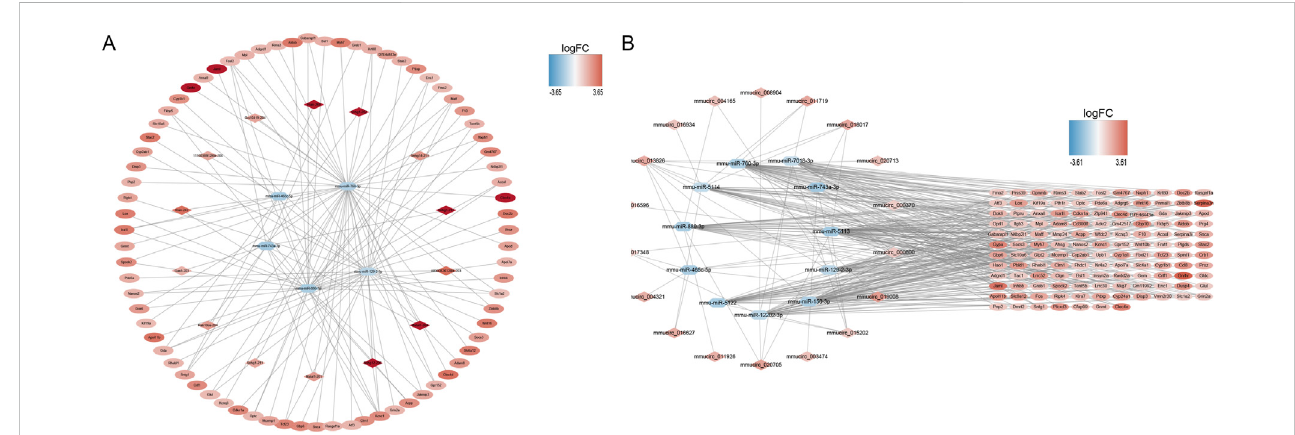
FIGURE 3 ceRNA network construction. (A) mRNA-miRNA-lncRNA network in control and case groups. (B) mRNA-miRNA-circRNA network in control and case groups. In the mRNA-miRNA-lncRNA (circRNA) network, the hexagon represents miRNA, the rhombus represents lncRNA (circRNA), the oval represents mRNA, and the color represents logFC value. The redder the color, the more upregulated the expression of the gene, and the bluer the color, the more downregulated the expression of the gene.